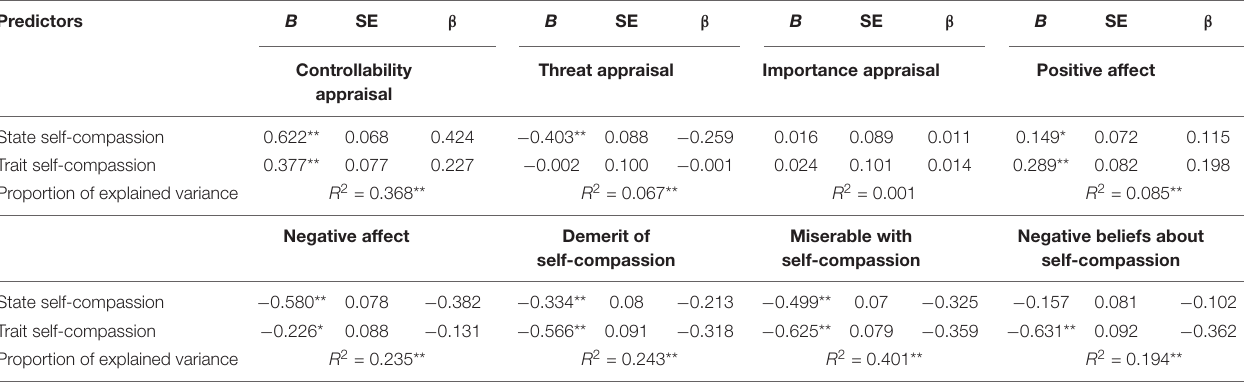
TABLE 6 | Path model of state and trait self-compassion in relation to cognitive appraisals, affect, fear of self-compassion, and negative beliefs about self-compassion.